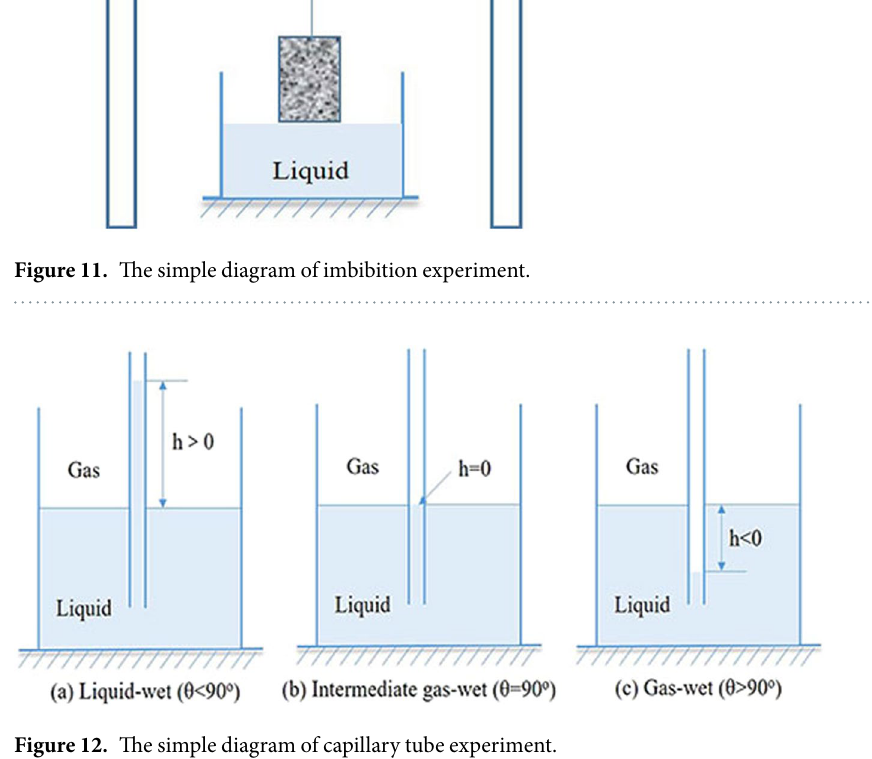
Figure 12. The simple diagram of capillary tube